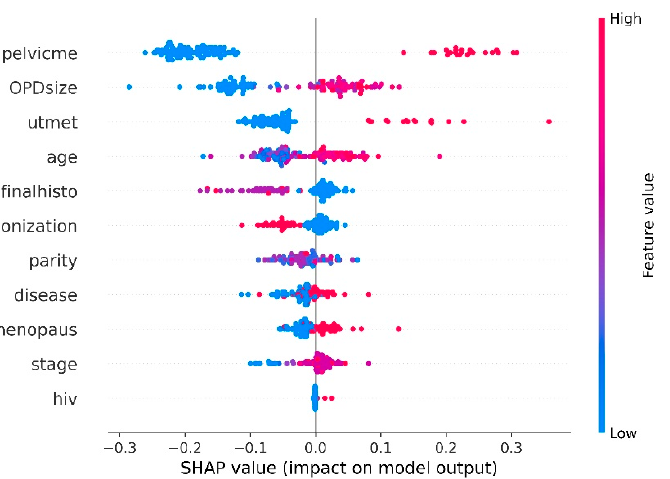
Figure 2. Clinicopathological factor analysis represents the relative importance for each factor obtained by averaging absolute SHAP values.